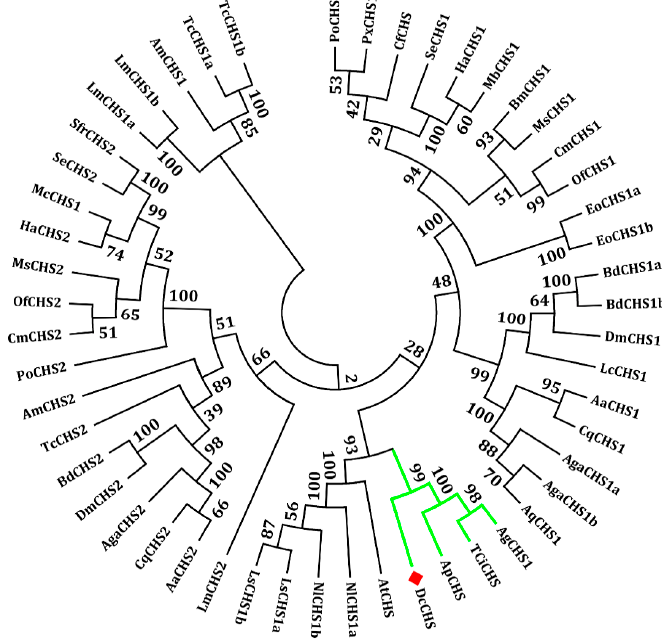
Figure 2. Phylogenetic relationships of DcCHS in different insect species using the neighbor-joining method with a bootstrap value of 1000. Chitin synthases were from Acyrthosiphon pisum (Ap), Aphis glycines (Ag), Laodelphax striatellus (Ls), Nilaparvata lugens (Nl), Bombyx mori (Bm), Choristoneura fumiferana (Cf), Cnaphalocrocis medinalis (Cm), Toxoptera citricida (TCi), Aedes aegypti (Aa), Culex quinquefasciatus (Cq), Drosophila melanogaster (Dm), Ectropis obliqua (Eo), Helicoverpa armigera (Ha),